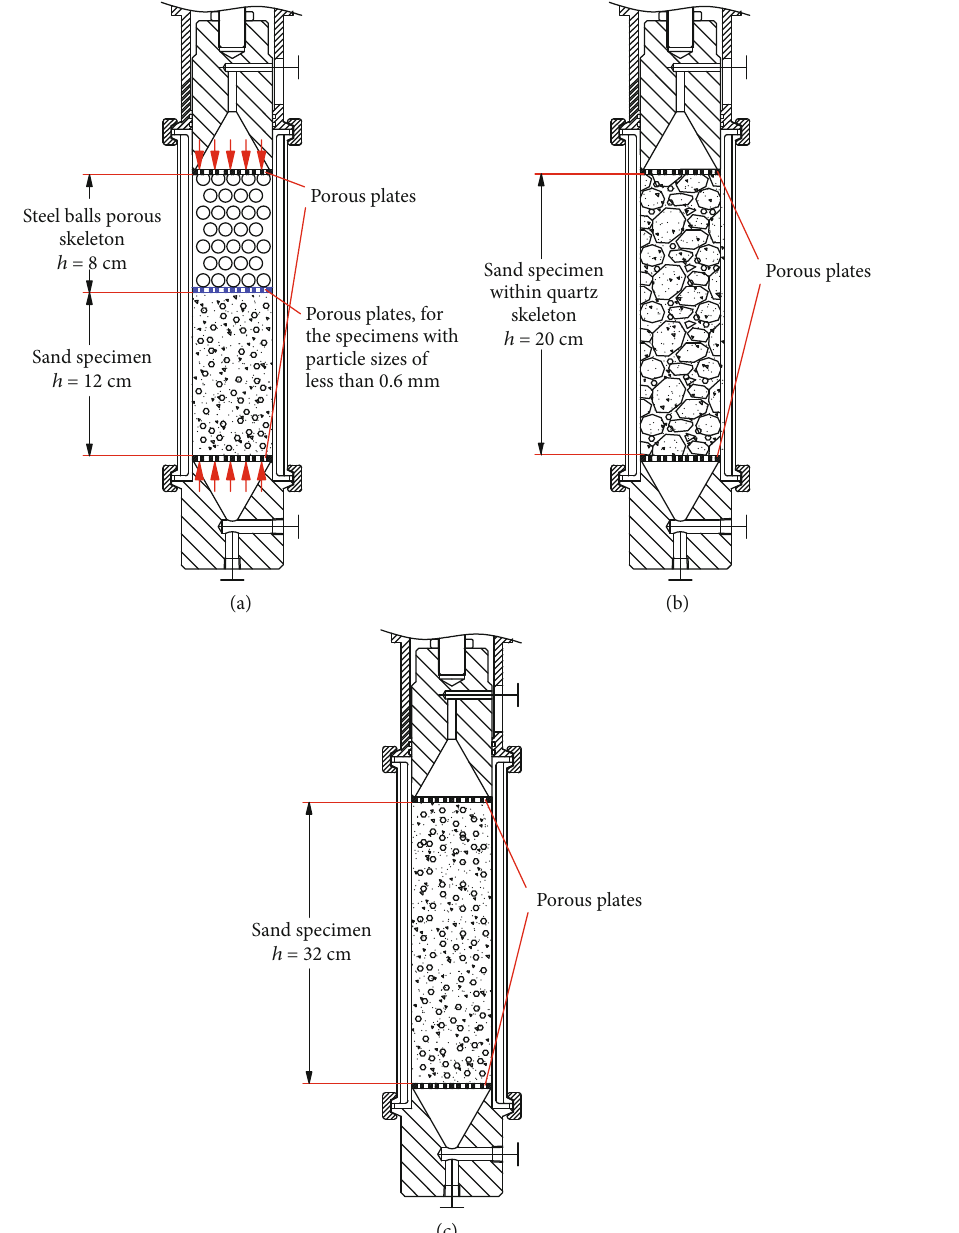
Figure 8: Sketch of the sample to be tested for (a) sand particle incipient motion tests, (b) sand particles migration in porous skeleton tests, and (c) water – sand mixture fl ow